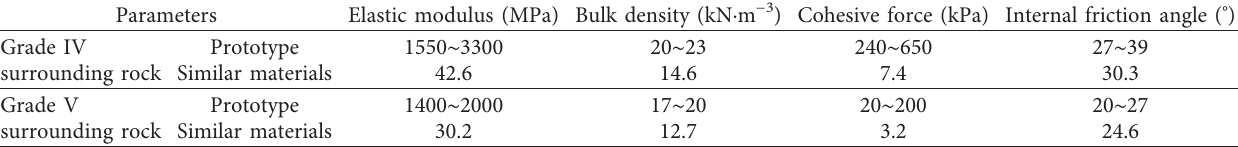
Table 4: Basic mechanical parameters of similar materials of surrounding rock.